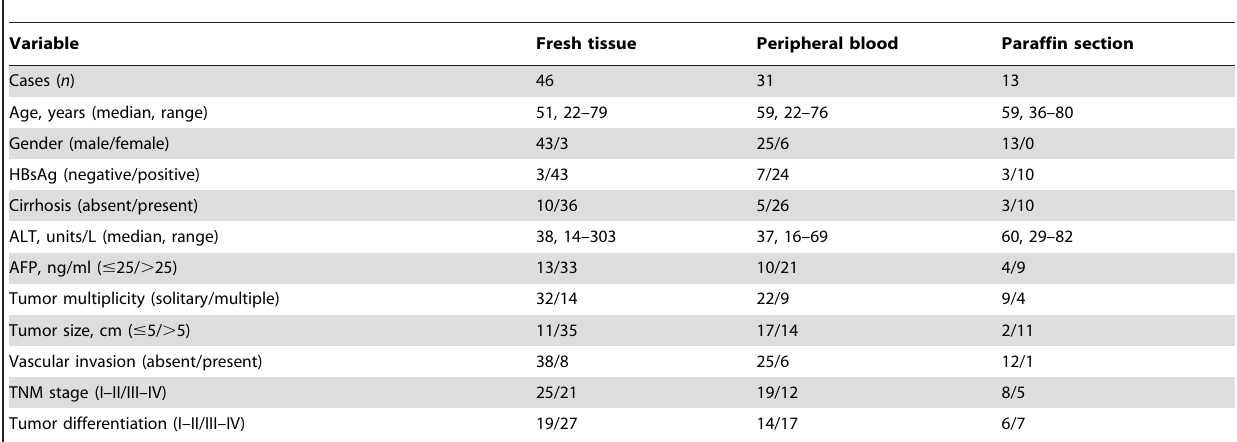
Table 1. Clinical and pathological characteristics of the HCC patients.